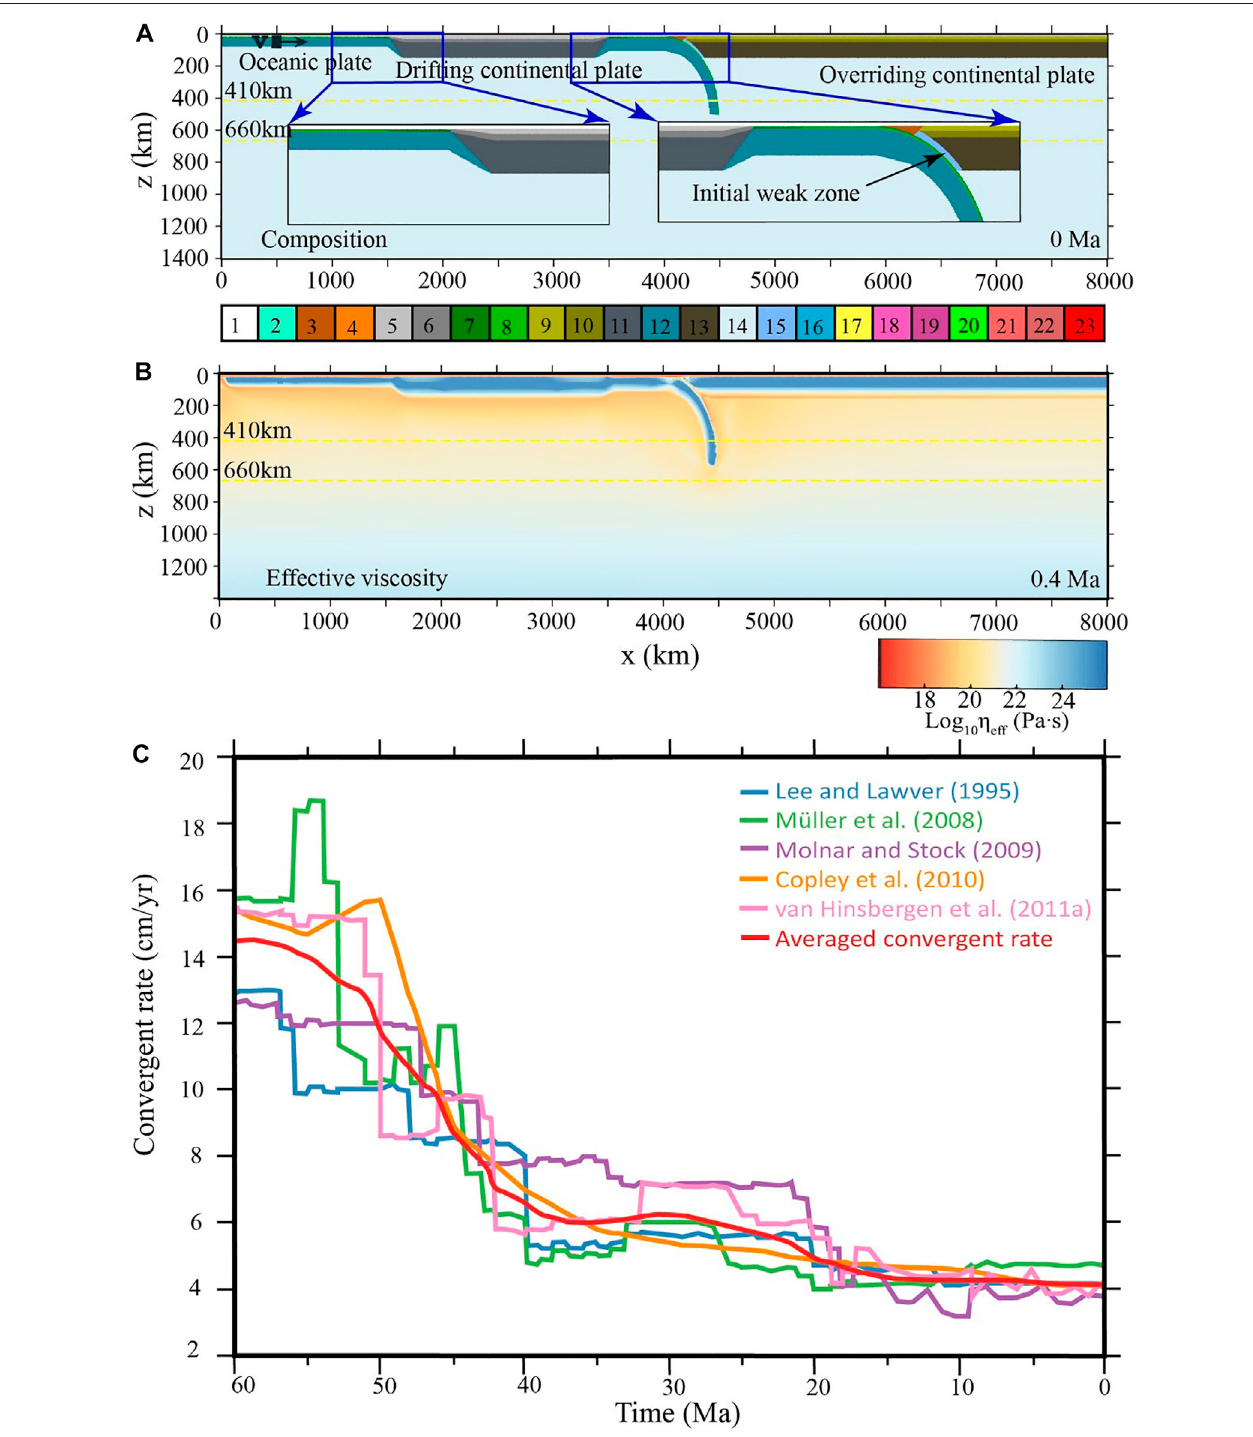
FIGURE 2 | Initial model con fi guration and boundary convergent rate. (A) Composition fi eld with colorbar shown at the bottom: 1, stick air; 2, seawater; 3,4, sediments; 5,6, drifting continental upper and lower crust, respectively; 7,8, oceanic upper and lower crust, respectively; 9,10, overriding continental upper and lower crust, respectively; 11, drifting continental lithospheric mantle; 12, oceanic lithospheric mantle; 13, overriding continental lithospheric mantle, 14, asthenosphere, 15, hydrated mantle; 16, serpentinized mantle; 17, partially molten sediments; 18, partially molten drifting continental upper crust; 19, partially molten drifting continental lower crust; 20, partially molten oceanic crust; 21, partially molten overriding continental upper crust; 22, partially molten overriding continental lower crust; and 23, partially molten mantle. (B) Effective viscosity fi eld with the colorbar shown at the bottom. The yellow dotted lines indicate the 410 and 660 km discontinuities,